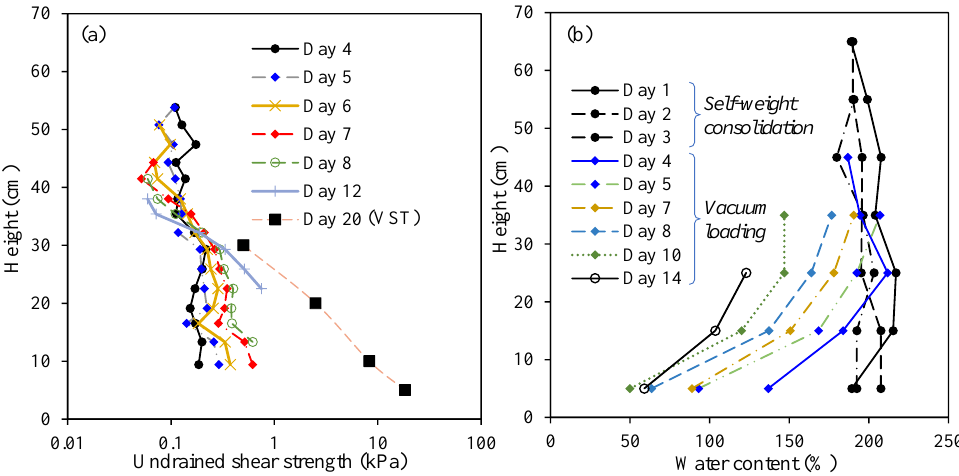
Figure 11. ( a ) Profiles of undrained shear strength; and ( b ) profiles of water content. The undrained shear strength measurement using the OFDR coin sensor with the fixed location is considered reliable when the surrounding soil has a significant settle- ment, for example during the sedimentation or self-weight consolidation. If the slurry has gained sufficient strength, shear strength measurement by pulling the OFDR coin sensor up or down is appreciated, which is presented in the next section.